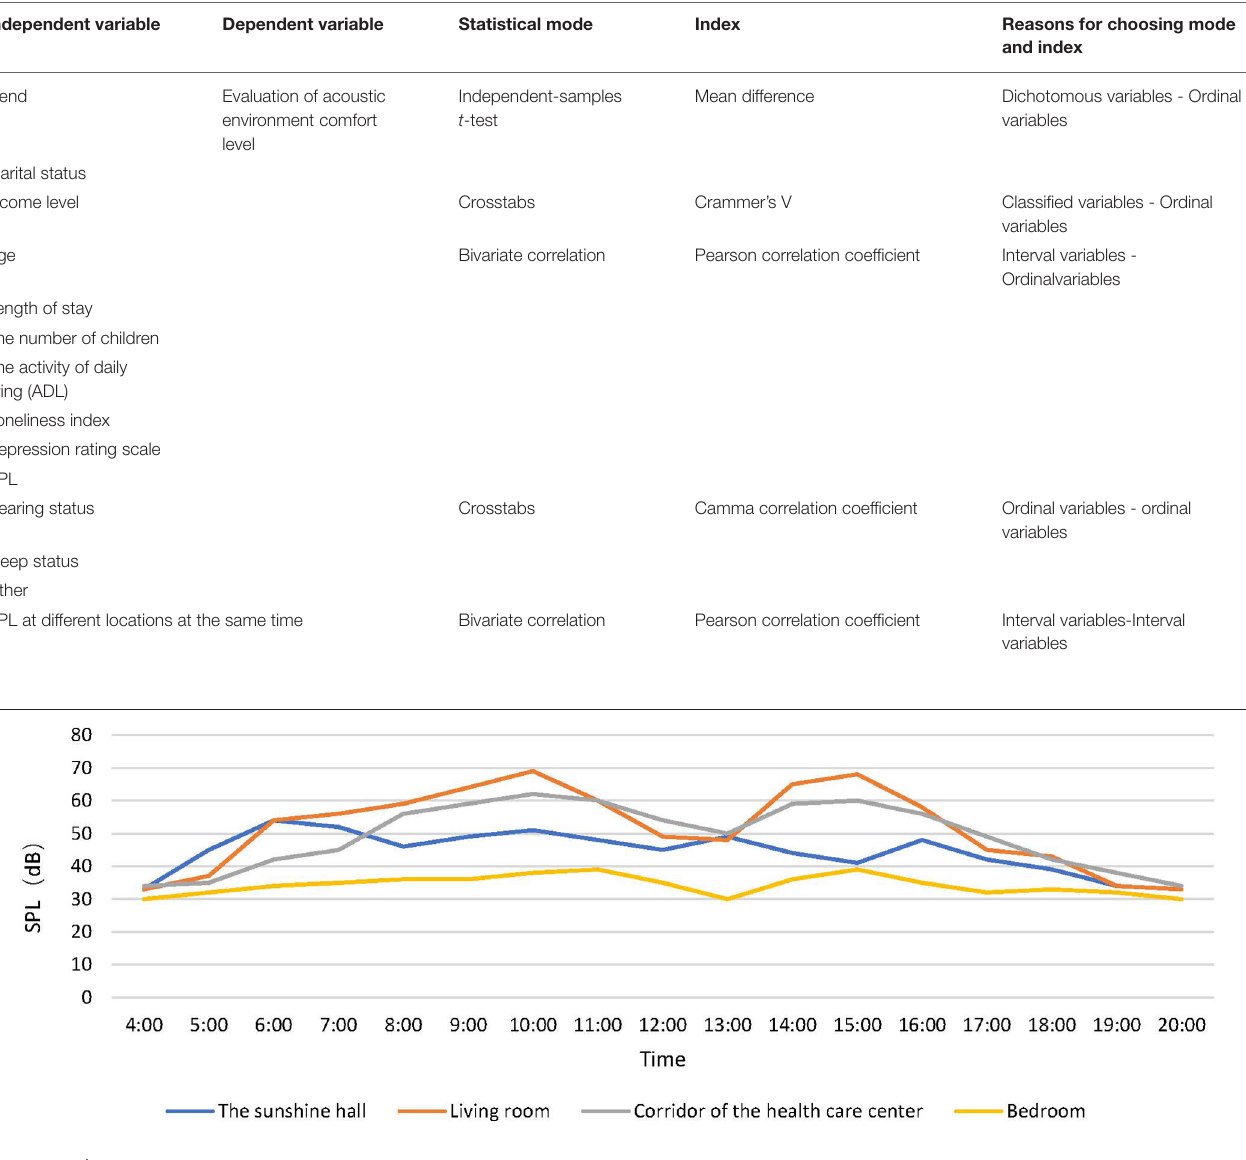
TABLE 2 | Correlation analysis and calculation methods of different independent variables and dependent variables.